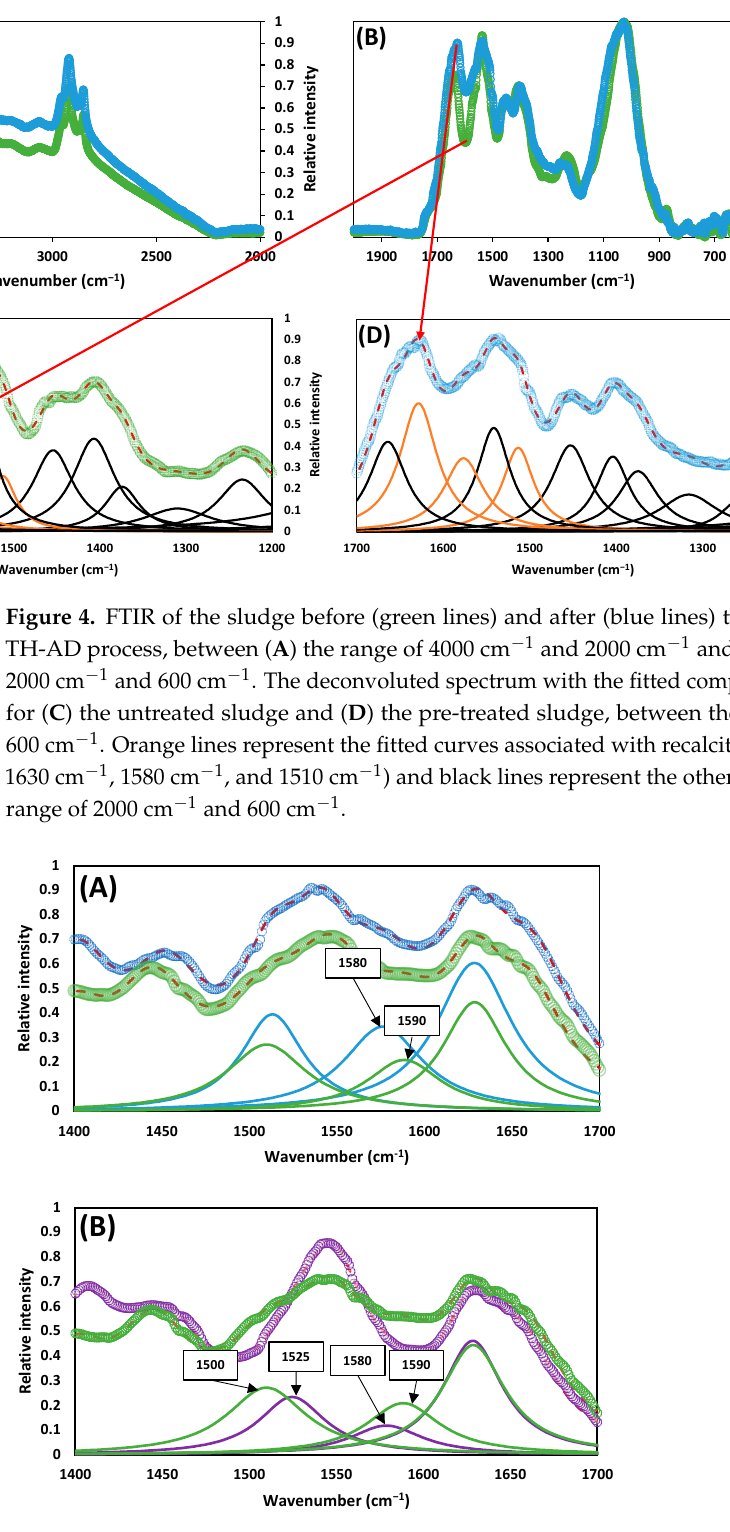
Figure 5. Comparison of the deconvoluted spectra with the fitted component bands at the range 1700 cm − 1 and 1400 cm − 1 of ( A ) the digested sludge after the TH-AD process (green) and the thermally pre-treated thickened activated sludge prior to its digestion in the TH-AD digester (blue) and ( B ) the digested sludge after the CAD process (purple) and the digested sludge after the TH-AD process (green).